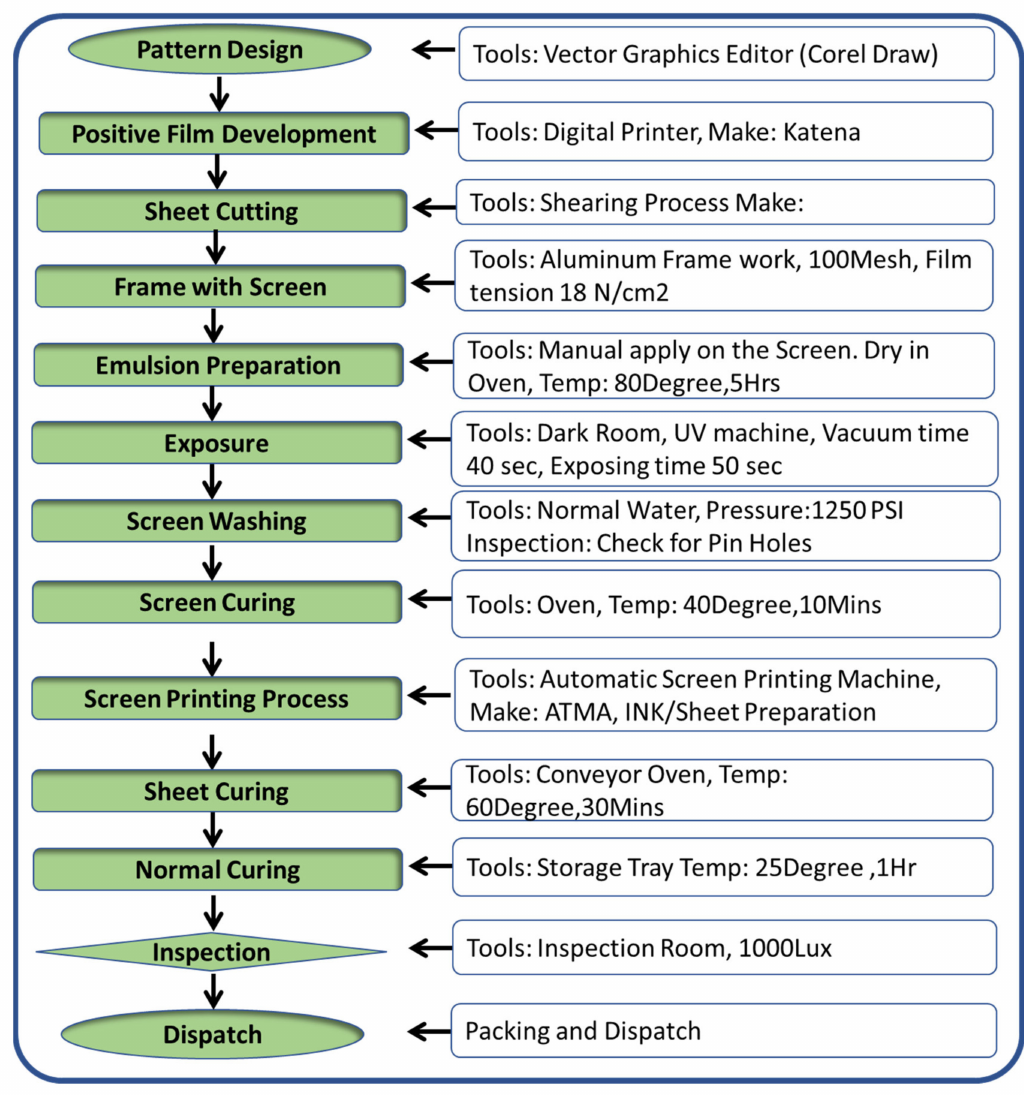
Figure 5. Steps involved in sensors fabrication process